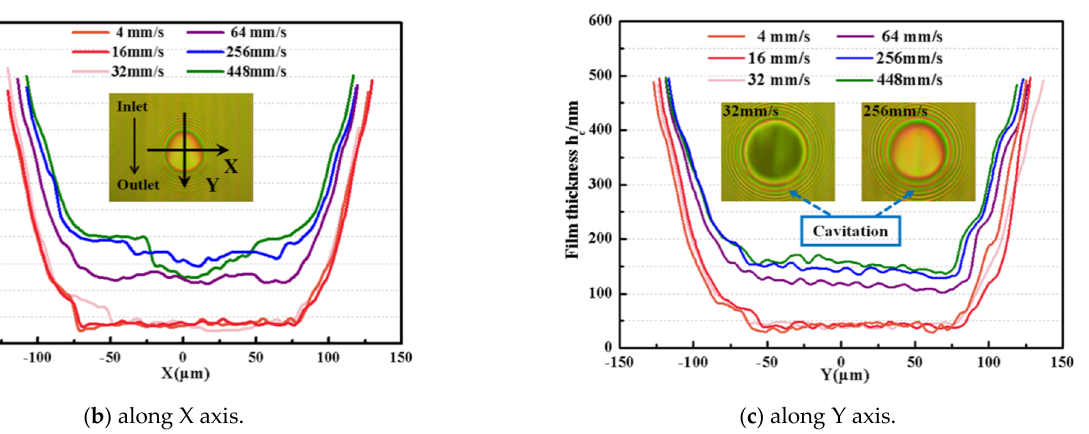
Figure 10. Film thickness curves and captured interferometric images in steel ball–glass disk contact grafted by polymer brush PSPMA at 4 N of load: ( a ) shows the film thickness values at different entrainment speeds as well as optical image; ( b , c ) show the film thickness values at different entrainment speeds along the X axis and Y axis.